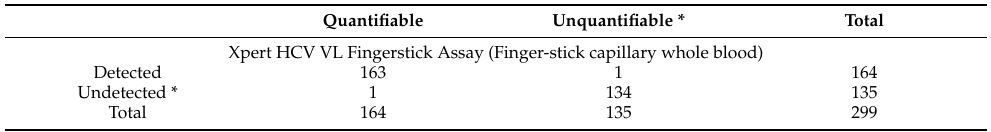
Table 4. Sensitivity and specificity of the Xpert HCV VL Fingerstick Assay for HCV RNA detection compared with the standard of care.